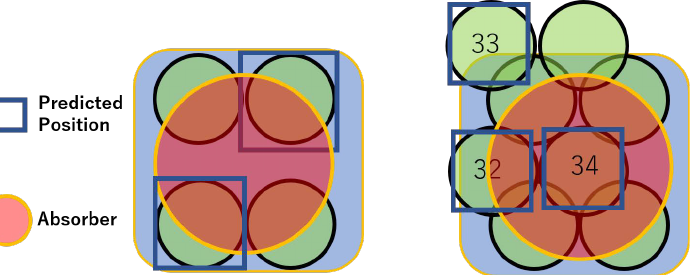
Figure 9. Example results for a big absorber. The left panel shows the classification for four domains, while the right panels shows eight domains. We apply a subtraction method for the case using four domains, but not for the case using eight domains. This figure shows the comparison between the results using a subtraction method and those for small domains without using subtraction. The red circle is the absorber, and predicted positions are indicated by blue